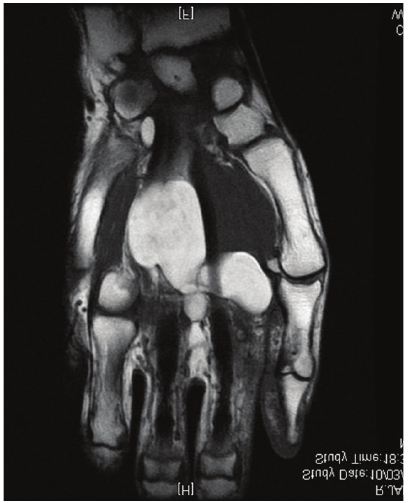
Figure 4: MRI frontal view showing tumor’s infiltration without invasion.